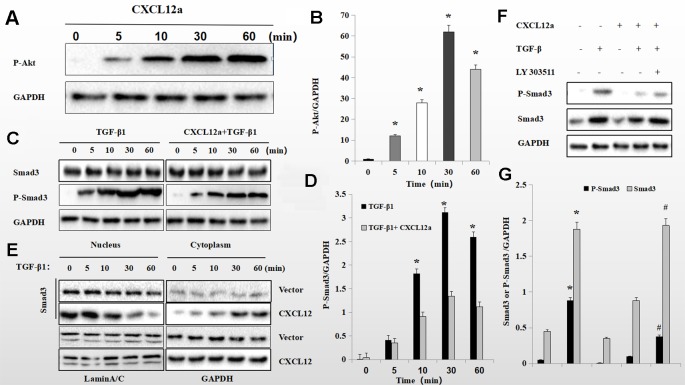
CXCL12a -induced phosphorylation of Akt downregulated TGF-β1-induced phosphorylation of Smad3. (A C, E) Rat primary chondrocytes were treated with CXCL12a (250 ng/ml), TGF-βp1 (10 ng/ml), or TGF-β1 (10 ng/ml) and CXCL12a (250 ng/ml) for the indicated times. Phosphorylated Akt, P-Smad3 and Smad3 levels by Western blotting. (B, D) Protein expression detected by western blotting was quantitated by densitometric analysis. (n = 4 per group, *p < 0.05). (F) Rat primary chondrocytes were treated with CXCL12a (250 ng/ml), TGF-β1(10 ng/ml), or Akt inhibitor (LY303511) for 48 h. P-Smad3 and Smad3 levels were determined by Western blotting. (G) Protein expression detected by western blotting was quantitated by densitometric analysis. Differences between treatments were analyzed using one-factor ANOVA and were considered significant for p < 0.05. *TGF-b1 compared to sham (p < 0.05); #CXCL12a+TGF-b1+LY303511 compared to CXCL12a+TGF-b1 (n = 4 per group p < 0.05).